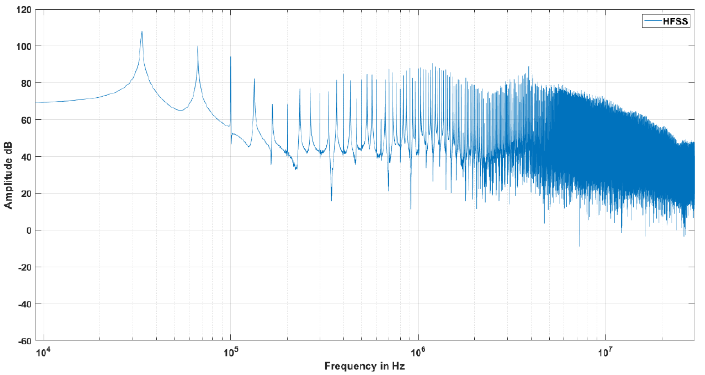
Figure 20. Conducted emission estimation using the HFSS approach. Frequency sweep 9 kHz to 30 MHz.